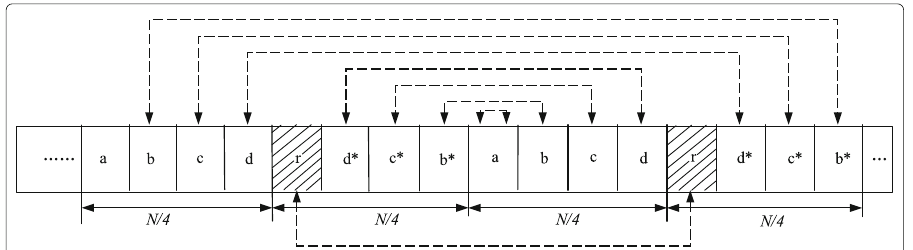
Fig. 4 Actual time domain symbol structure of Park